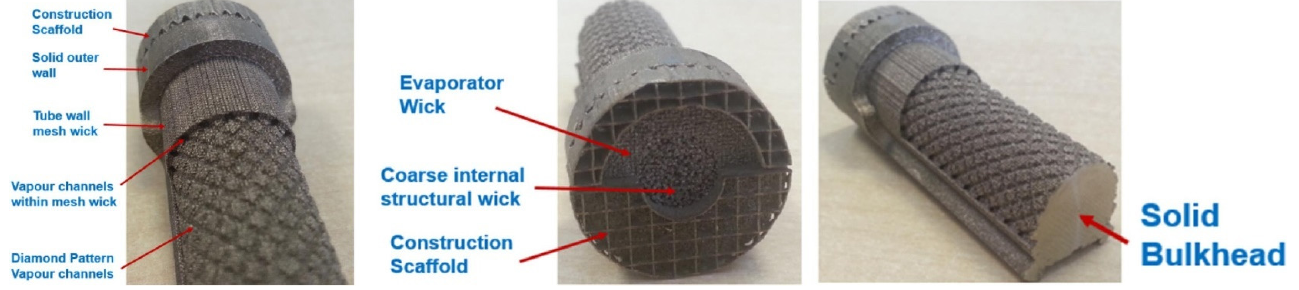
Figure 10. AM LHP evaporator [17].